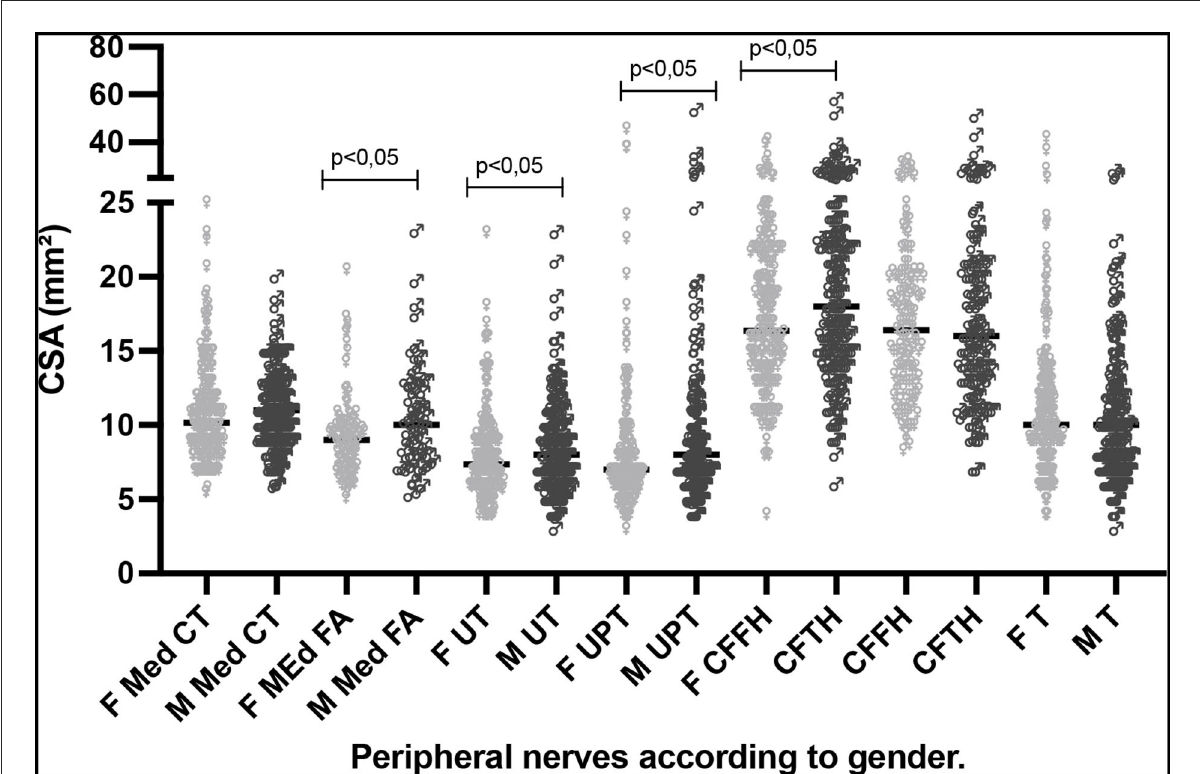
FIGURE2 Distribution of CSA (mm 2 ) values at neural sites according to male and female gender for the age range of 15–60 years. F, female; M, male; CSA, cross-sectional area; Med CT, median carpal tunnel; Med FA, median forearm; UT, cubital ulnar tunnel; UPT, cubital ulnar pretunnel; CFFH, common fibular head of the fibula; CFTH, common fibular thigh; T,